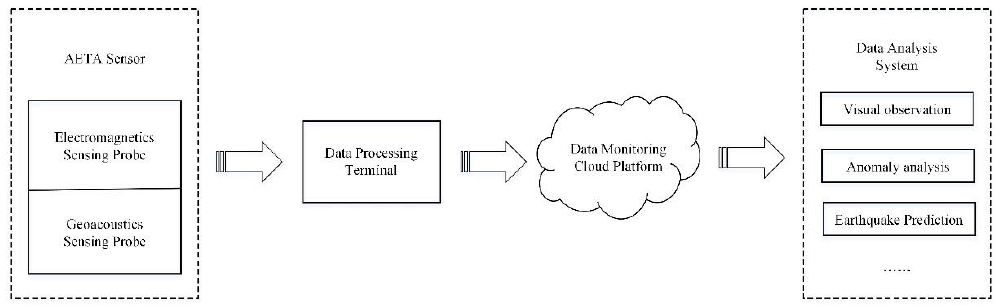
Figure 1. Block diagram of AETA system.